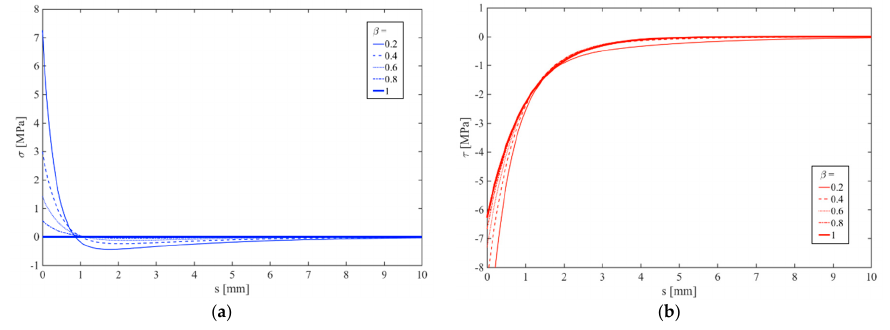
Figure 17. Effect of the mechanical ratio β on the interface local response: ( a ) Normal stress; ( b ) Tangential stress. (Isotropic specimen). J. Compos. Sci. 2018 , 2 , x FOR PEER REVIEW